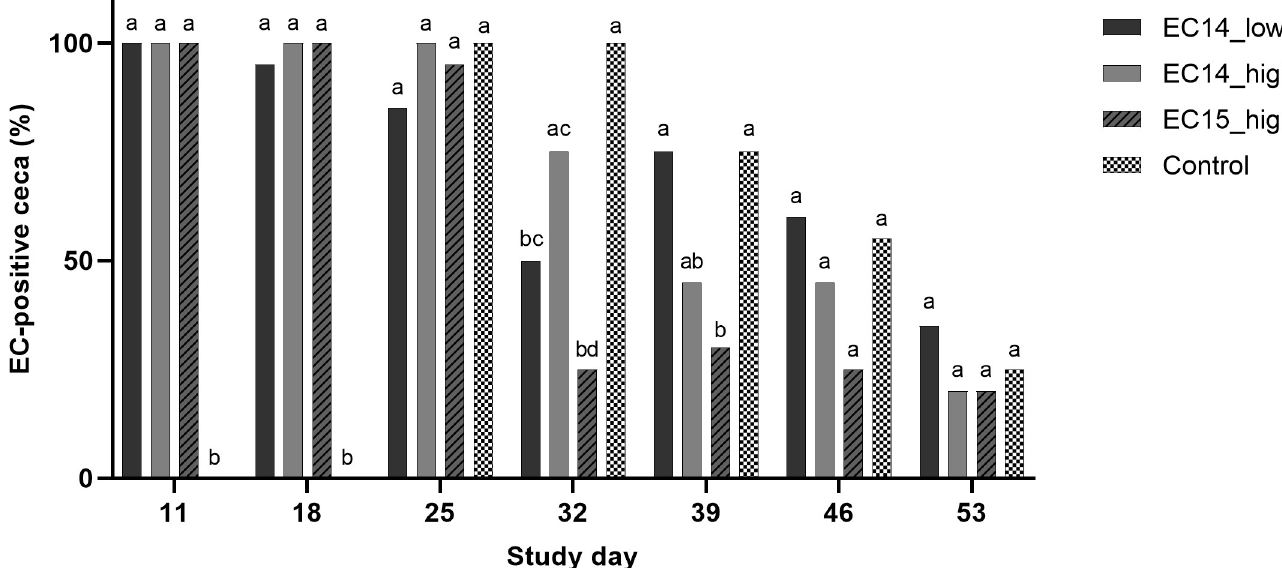
Fig 5. Cecal colonization by EC. Samples were analyzed via real-time PCR, and Ct values below 36 were considered positive. Different letters indicate significant differences between the groups per study day ( p � 0.05). Comparison between the groups was made for each study day by using Fisher’s exact test. p -value adjustments for multiple testing were performed by using the Bonferroni-Holm correction method. N = 20 per group and study day.